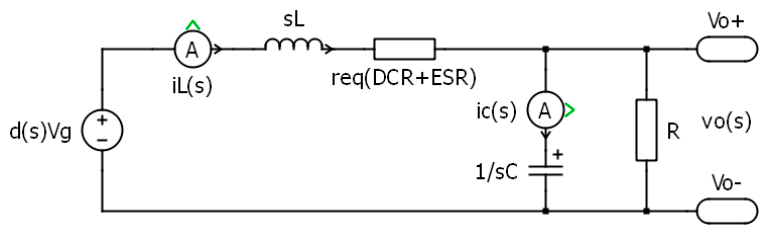
Figure 3. A small signal equivalent open loop Buck converter.